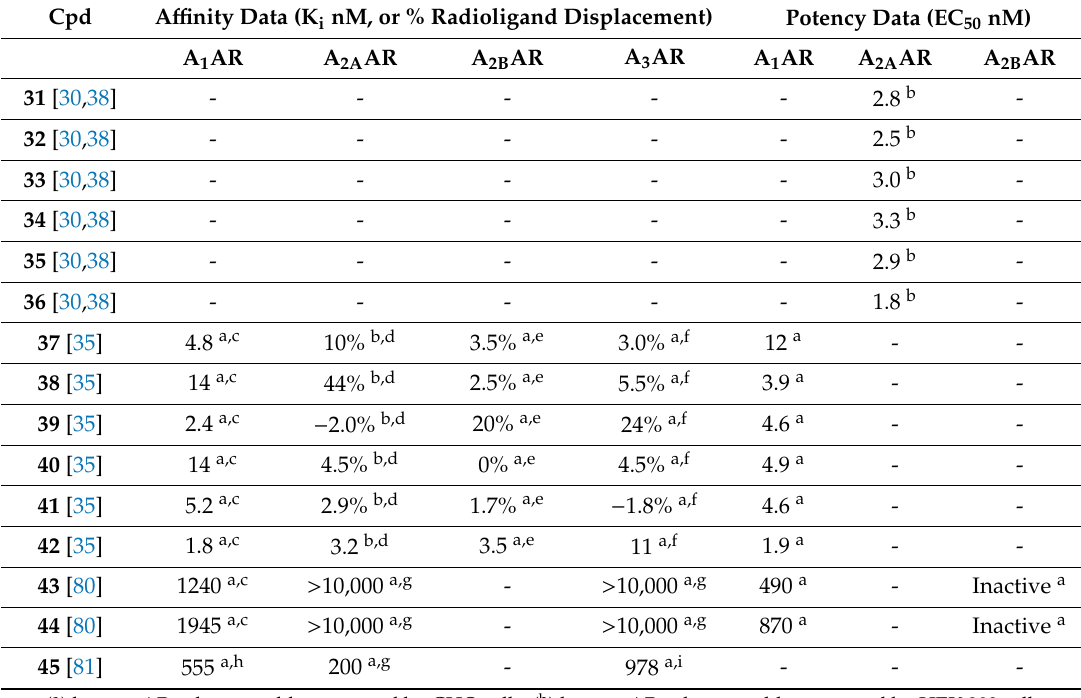
Table 2. Binding a ffi nity (K i ) and potency (EC 50 ) data of selected pyrimidine-based non-nucleoside agonists of the